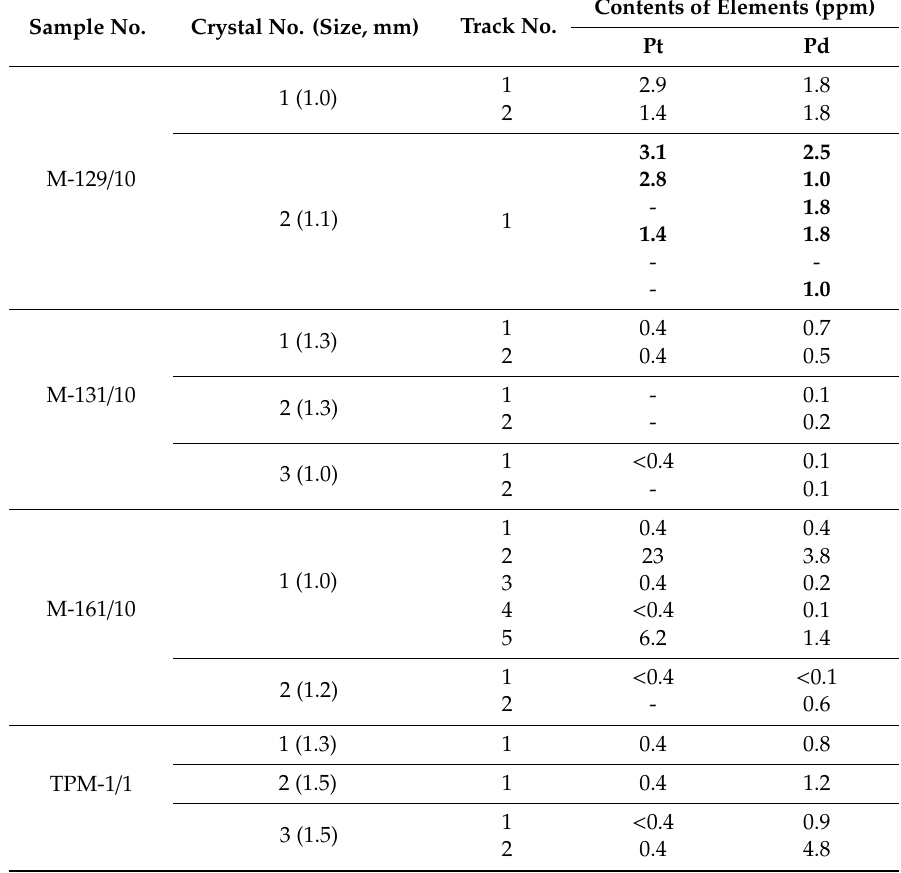
Table 10. Results of LA-ICP-MS analysis of the surface of arsenopyrite crystals for Pt and Pd (the Natalkinskoe deposit). Sample No. Track No.